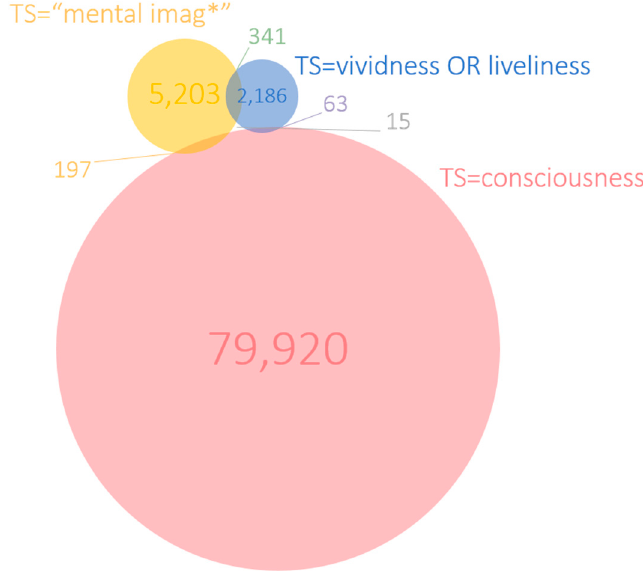
Figure 5. Venn diagram of the co-occurrence of terms in the title, abstract or keyword (TS) fields.